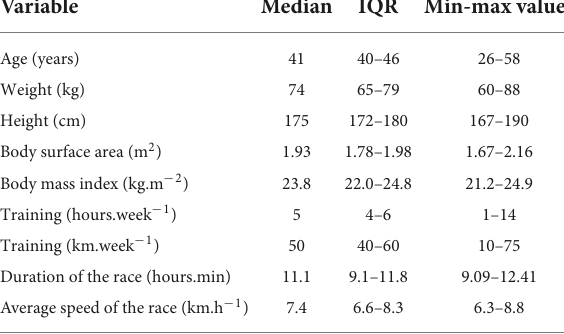
TABLE 1 Characteristics of 20 amateur ultra-distance and trail